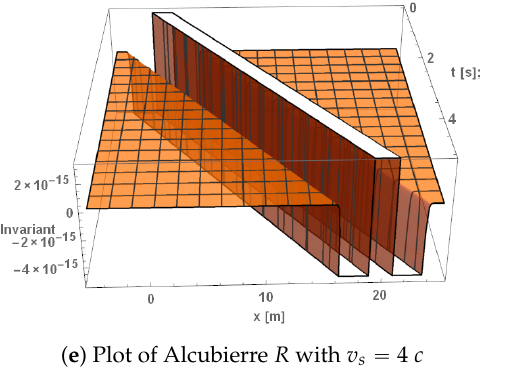
Figure 1. Plots of the R invariants for the Alcubierre warp drive while varying its velocity. σ = 8 m ´ 1 and ρ “ 1 m as Alcubierre originally suggested in his paper [1]. Equation (8) is in natural units, so the speed of light was normalized out of the equation. The factor of c was included in these captions to stress that the plots are of multiples of the speed of light. Their units are m s ´ 1